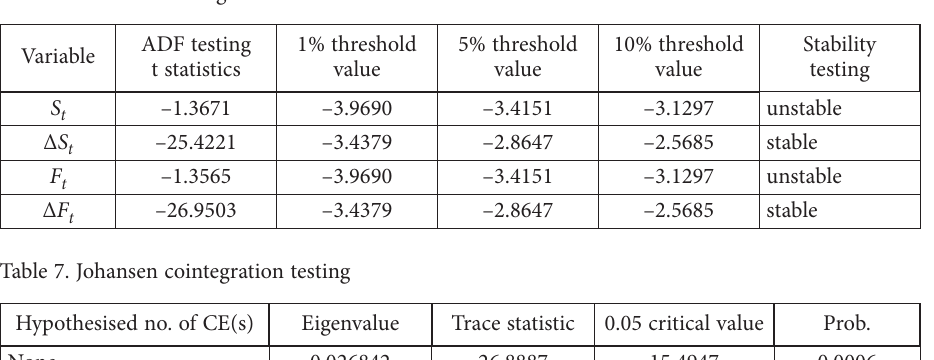
Table 6. Unit root testing